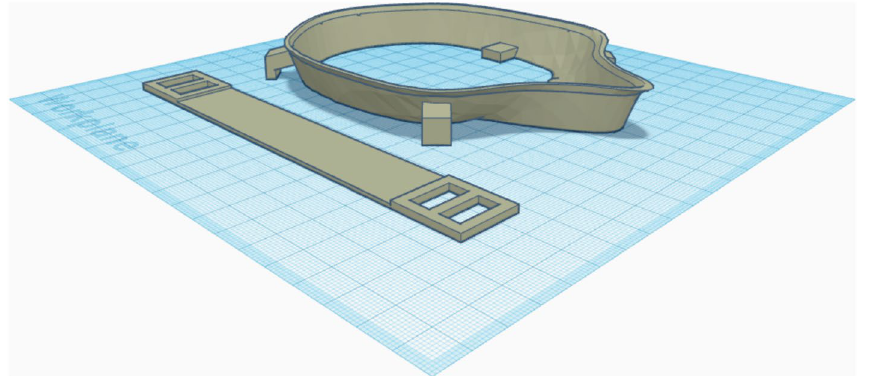
Figure 7. Finished 3D designs of the statistically shaped mask frame and